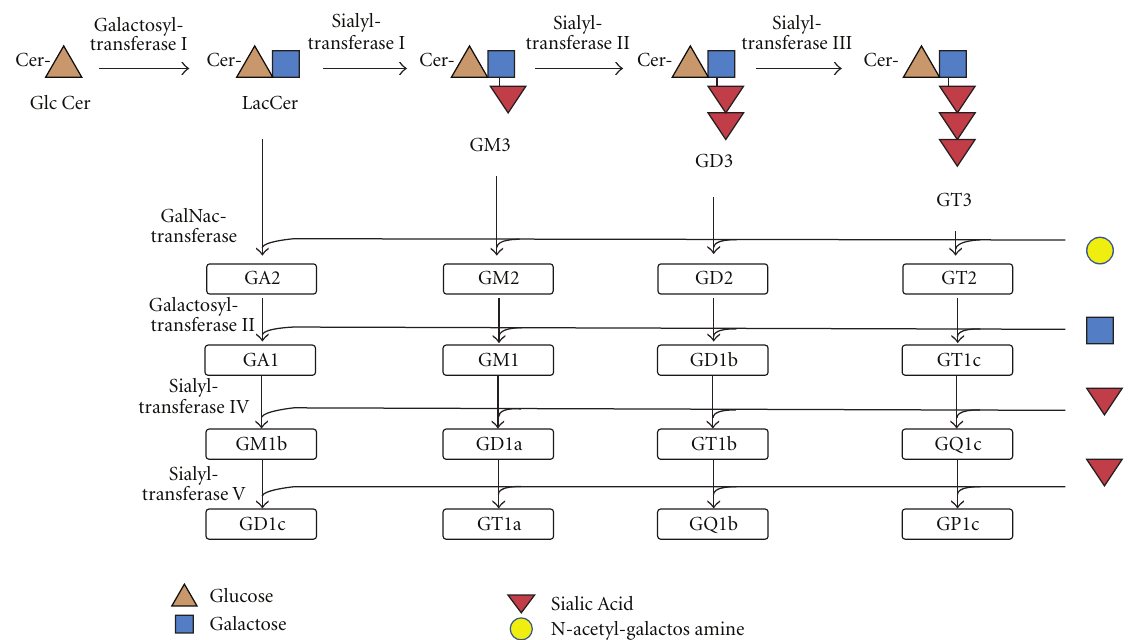
Figure 1: General scheme for ganglioside synthesis. Network of ganglioside synthesis; steps are also reversible. “G” denotes “ganglioside;” “A” denotes “asialo” or lacking sialic acid; “M” denotes “monosicalo,” “D” denotes “disialo;” numbers denote carbohydrate sequence. Adapted from Malisan and Testi [6]. Cer: ceramide; GlcCer: glucosylceramide; LacCer: lactosylceramide; GalNac: N-acetylgalactosamine.